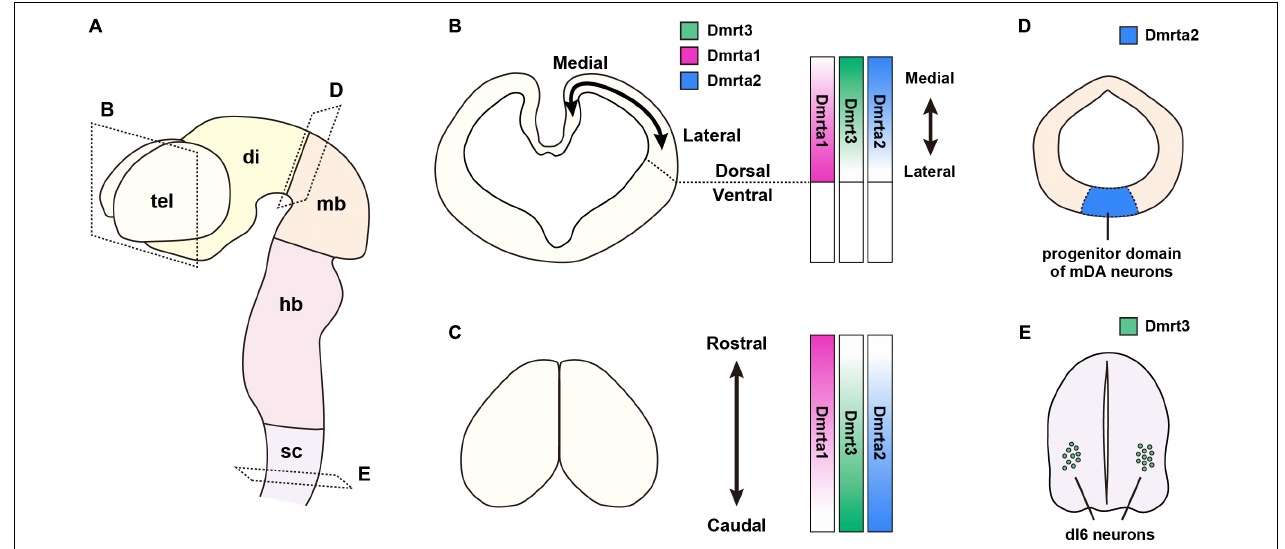
FIGURE 1 | Expression patterns of DmrtA subfamily members in the embryonic mouse CNS. (A) Schematic representation of the mouse embryonic CNS at E11. (B–E) Expression pattern of DmrtAs. (B) Cross-sections of the telencephalon. Magenta indicates the expression of Dmrta1; green, Dmrt3; and blue, Dmrta2. DmrtAs are expressed in NSPCs in the dorsal telencephalon. Dmrta1 expression has a medial-low/lateral-high gradient, whereas Dmrt3 and Dmrta2 show a medial-high/lateral-low gradient. (C) Dorsal view of the telencephalon. Dmrta1 is expressed in a rostral-high/caudal-low gradient, whereas Dmrt3 and Dmrta2 show a rostral-low/caudal-high gradient. (D) Cross-sections of the midbrain. Dmrta2 is expressed in the progenitor domain of mDA neurons in the ventral midbrain. (E) Cross-sections of the spinal cord. Dmrt3 is specifically expressed in dI6 neurons in the spinal cord. CNS, central nervous system; di, diencephalon; dI, dorsal interneuron; DmrtAs, DmrtA subfamily members; hb, hindbrain; mb, midbrain; NSPCs, neural stem progenitor cells; sc, spinal cord; tel,